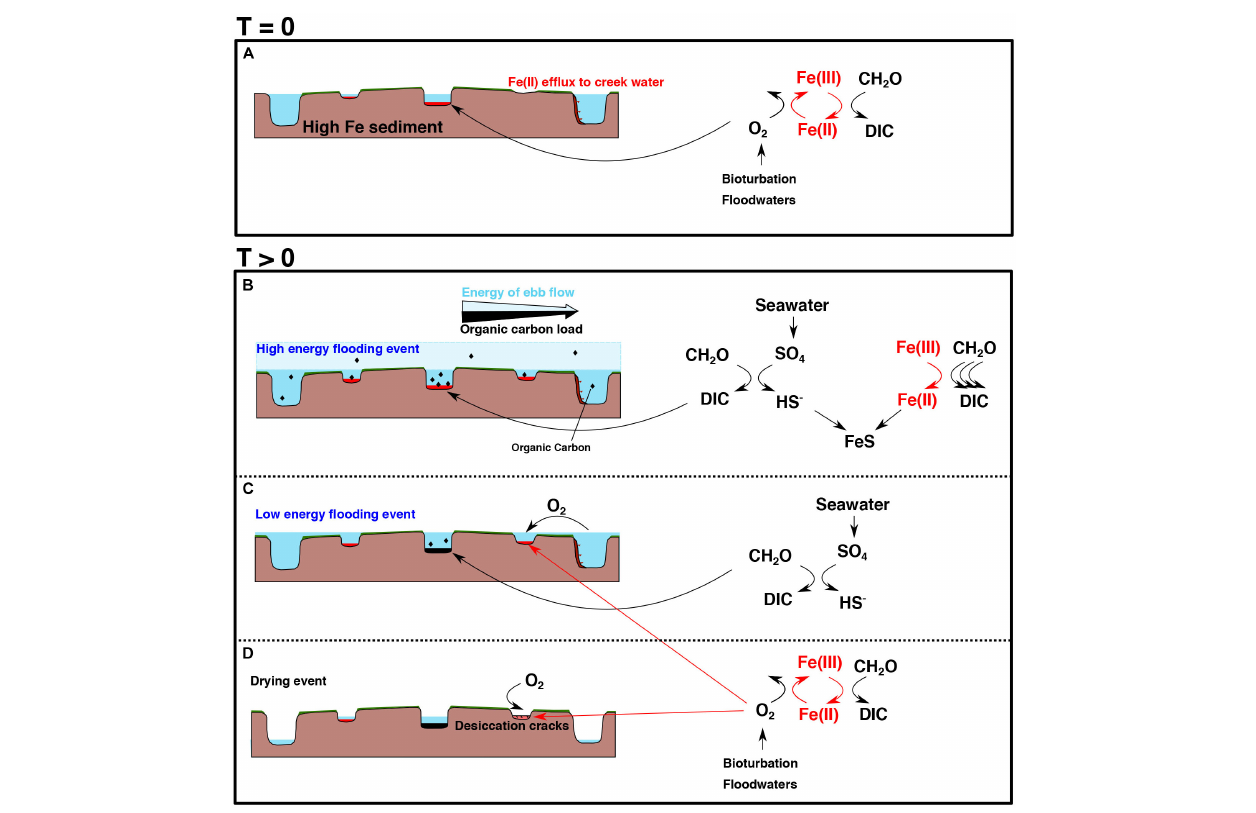
FIGURE 12 | Schematic of potential mechanisms driving pond chemistry heterogeneity over a salt marsh platform. Vertical scale is exaggerated (likely elevation differences are within a meter). (A) Represents an earlier stage of development [T (time) = 0] in a salt marsh platform whereas (B–D) represent changes over time [T (time) > 0] (e.g., the effects of deeper, older ponds and the potential transitioning of pond sediment geochemistry). (A) Due to the high iron content of the sediment, all ponds should, in theory, have an iron-rich pond sediment geochemistry. The reaction shows bacterial iron reduction (BIR) reducing organic matter, with oxygen supplied from bioturbative-mixing and oxic flood waters, which acts to regenerate the ferrous iron. Fe(II) efflux to creek demonstrates the unknown diffusive flux at the creek wall boundary ( Figure 5 ). (B) Periods of extremely high flooding (storm events or very high tides) from tidal creeks. All ponds are flushed with seawater and organic carbon will be deposited. As the energy of the ebb flow decreases during retreat (due to friction with the vegetated surface), the suspended organic carbon load will decrease as the flow returns to the creeks. If the central pond has sufficient organic matter to exhaust the ferric iron pool, microbial sulfate reduction can occur (see reaction alongside diagram), using seawater sulfate as the electron acceptor. This will slowly act to titrate ferrous iron as iron monosulfides, possibly acting as a switch to sulfide-rich conditions (C). (C) Low energy flooding events which may only flood ponds closer to the creeks introduces oxic water. The interior pond is assumed to have negligible available ferric iron supply so sulfide-rich pond sediment conditions are achieved. (D) Periods of excessive dry weather on the salt marsh platform (as observed in July 2018). Differential water head is attained due to the low hydraulic conductivity of the clay-rich sediment. More central ponds, having a deeper water column initially, are less susceptible to full evaporation. When the water column is fully evaporated, deep ( < 15 cm) desiccation cracks can occur, allowing atmospheric oxygen into the sediment. Further oxygen may be added upon submergence of the pond sediment with oxic seawater and potential bioturbating